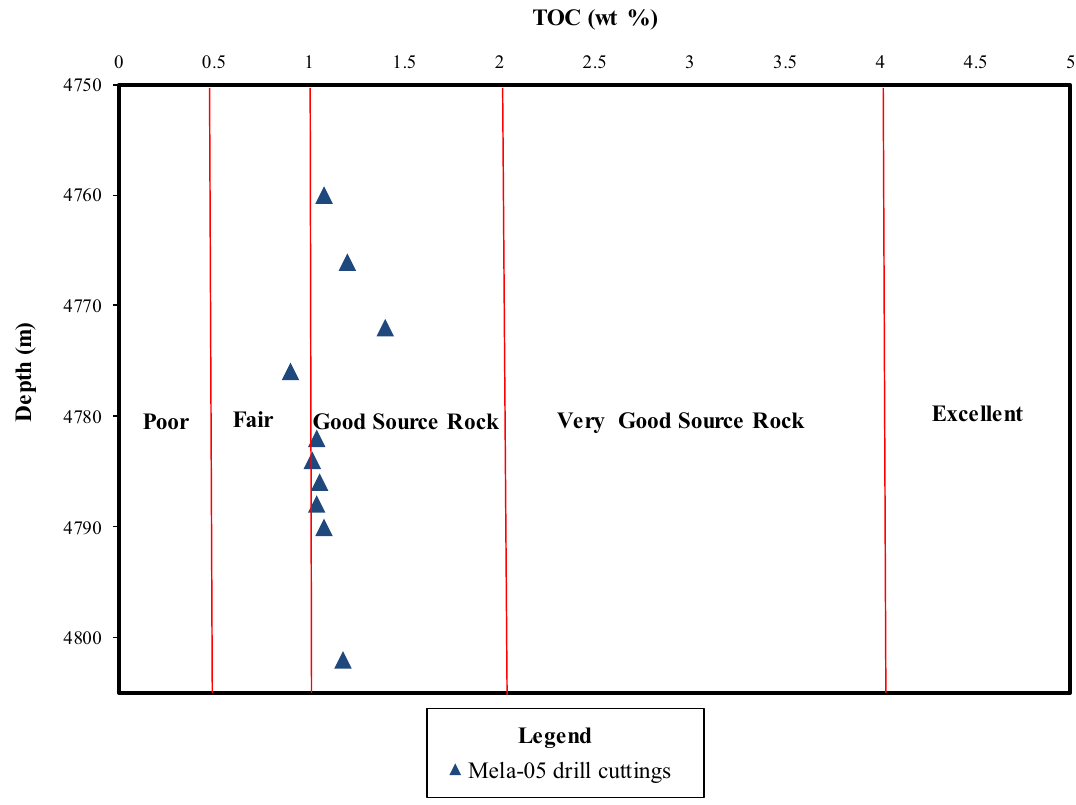
Fig. 2 The cross-plot of depth vs TOC, showing the distribution of TOC (wt%) in the Mela-05 drill cuttings of the Chichali Formation